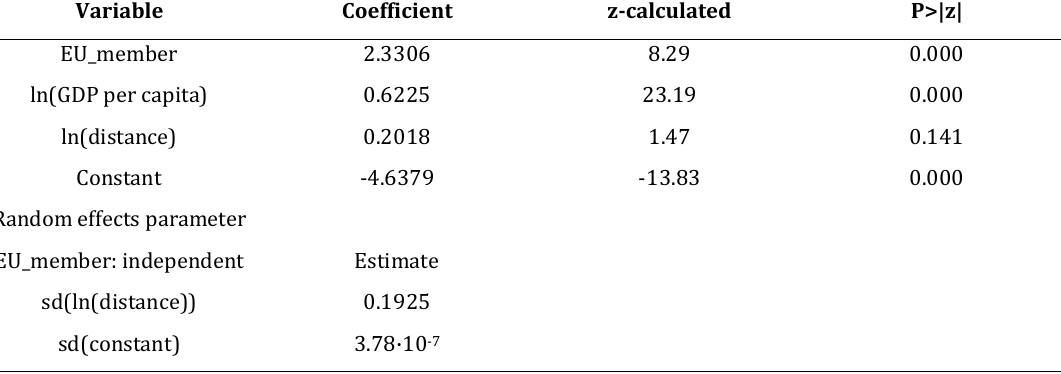
Table 2: Mixed-effects Poisson model (M1) for explaining the number of FDI projects in the UK (2012-2015)